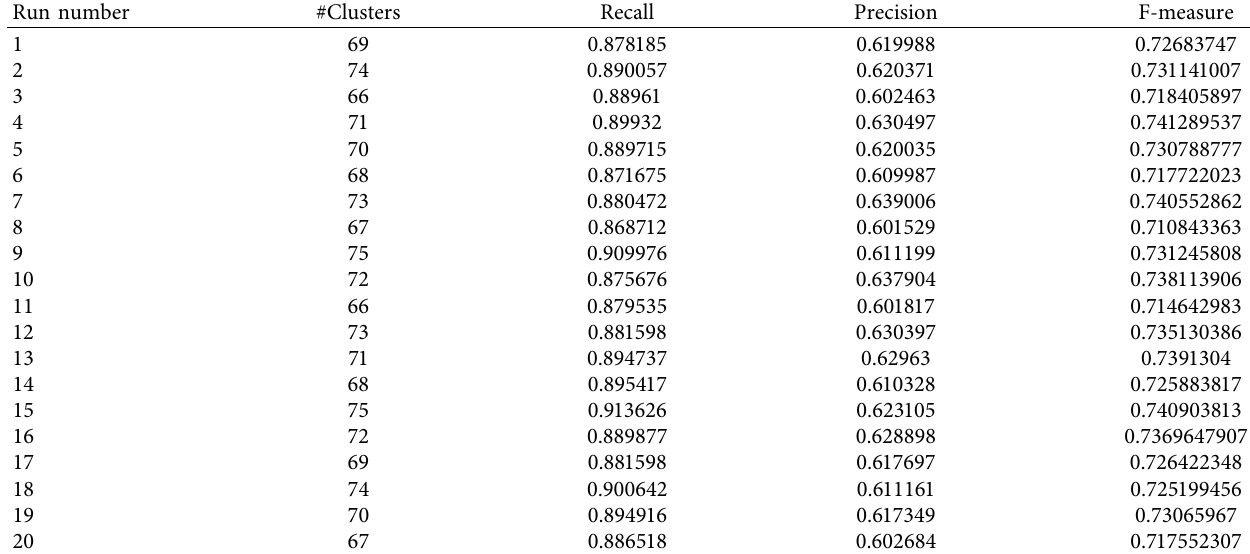
Table 3: Collins data sample clustering results in 20 independent runs (CYC2008 complex